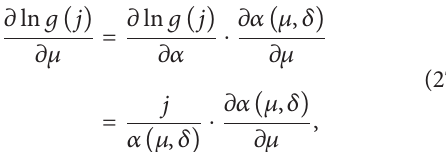
Table 2: Goodness-of-fit (chi-square and 𝑝 value with the last two regrouped